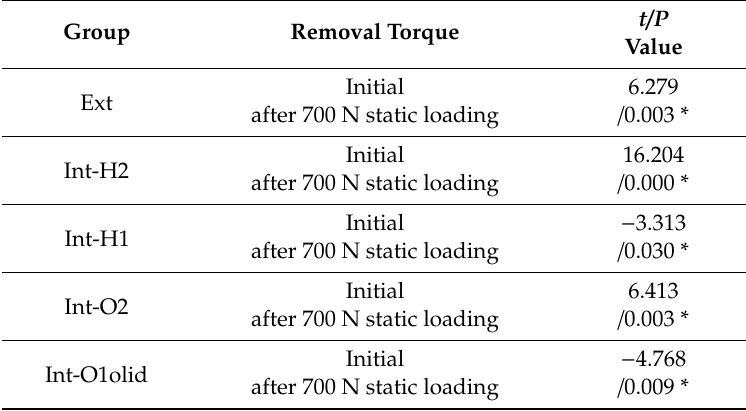
Table 6. Comparisons of the mean values of initial removal torque and removal torque after static loading in each group.